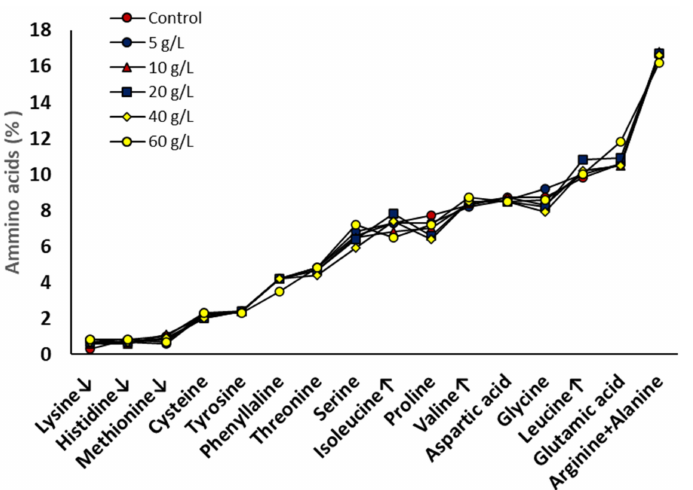
Figure 5. Amino acids of A. platensis grown at different salinities. Arrows denote the higher or lower values compared to the recommended values of FAO